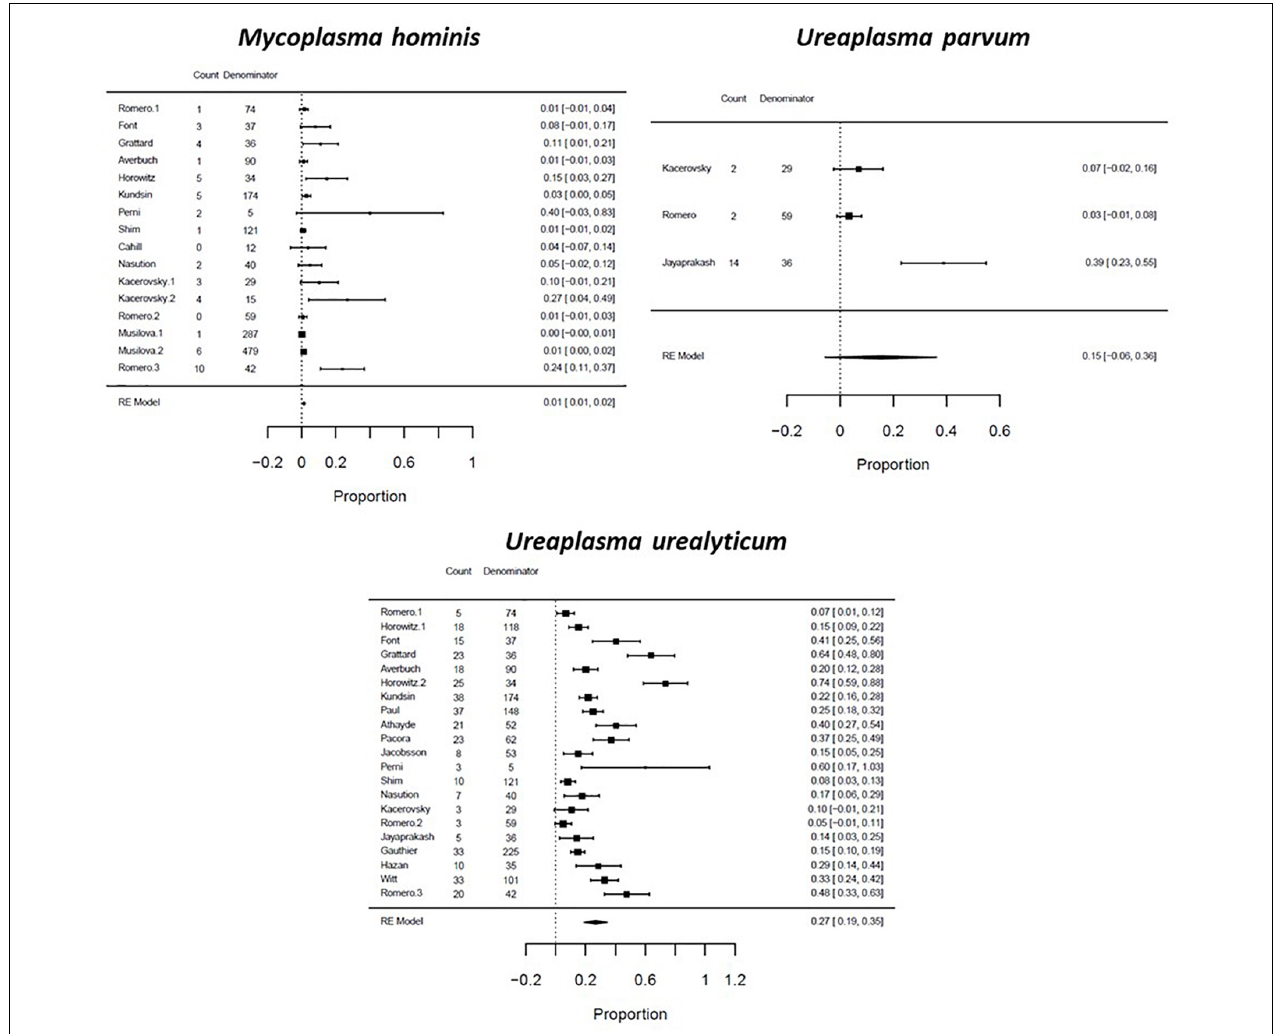
FIGURE 6 | Forest plot for the pooled proportion of genital Mycoplasma infection among preterm prelabor rupture of membranes (PPROM)